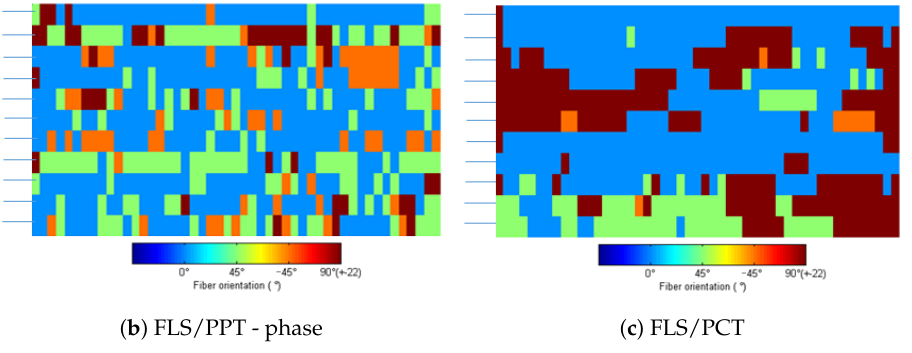
Figure 10. Classification results of fiber orientation obtained with samples not used during the training stage for the best image processing techniques (PCT and PPT). Results are color coded according to the color used in Figure